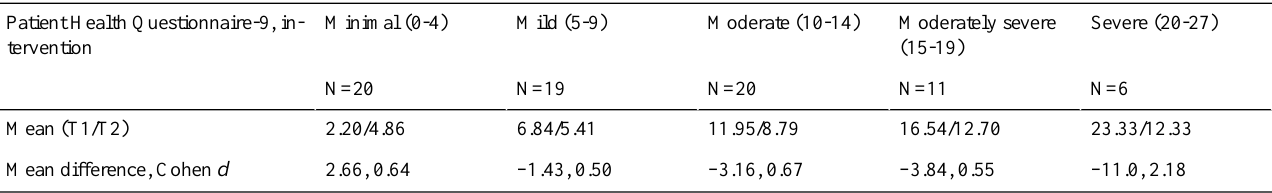
Table 5. Analysis of Patient Health Questionnaire-9 subgroups: intervention.